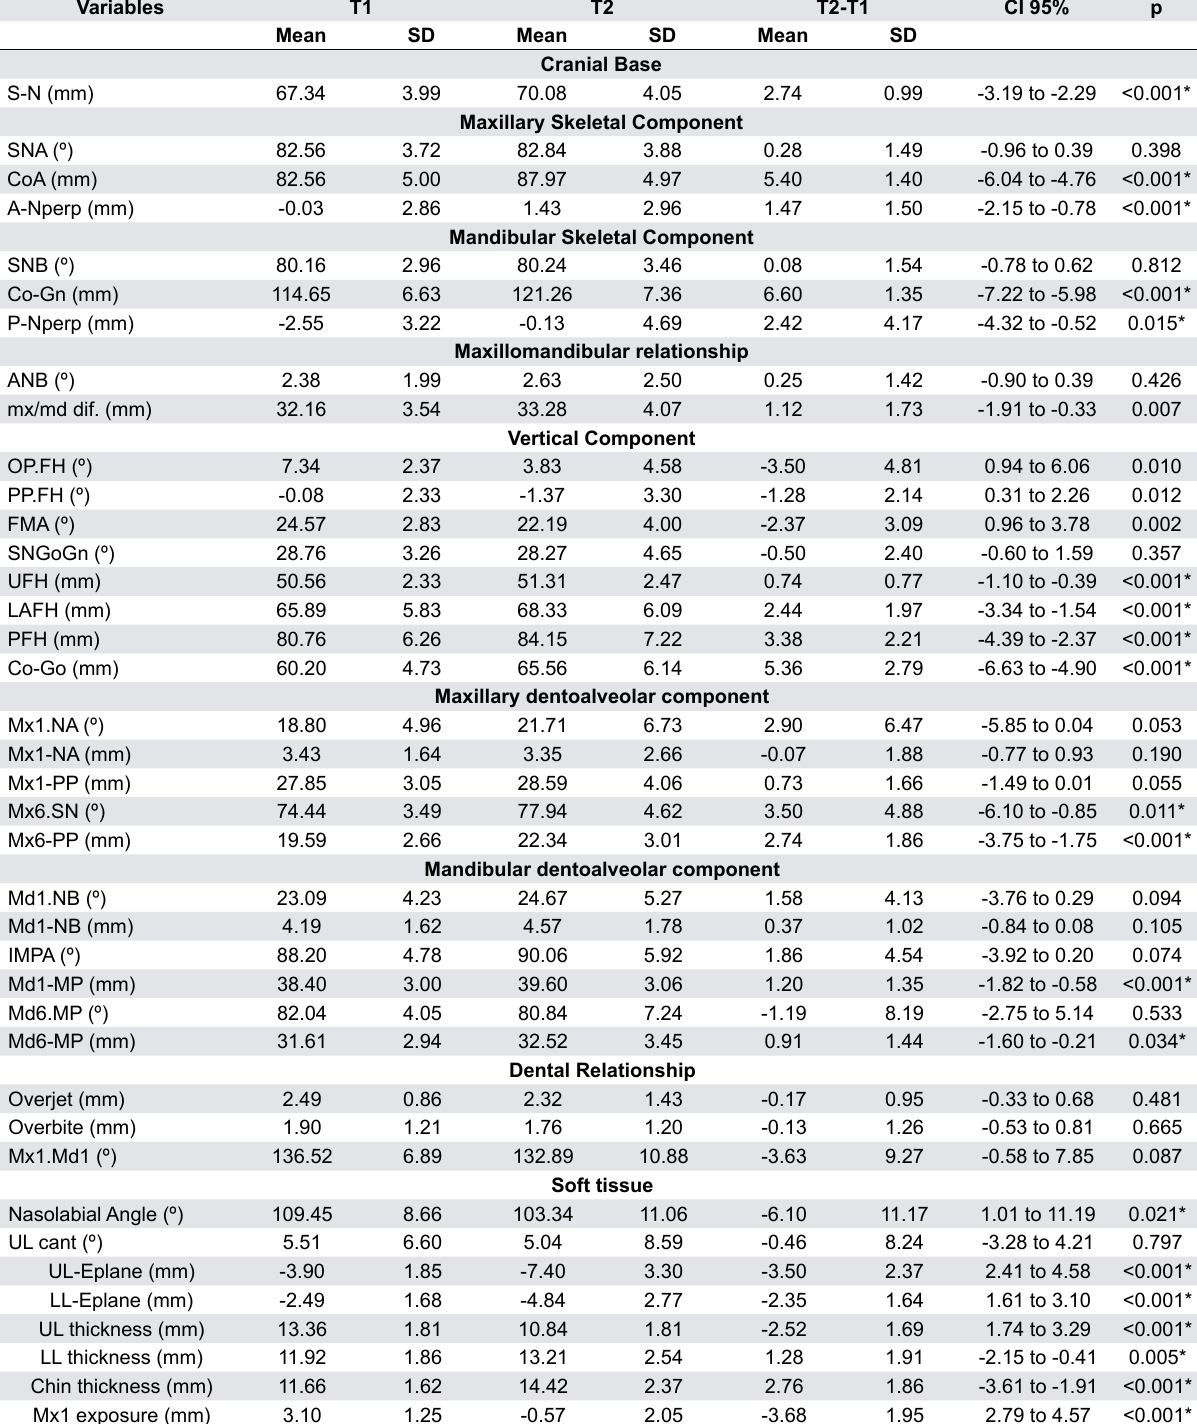
Table 2- Interphase comparisons in all 21 subjects (paired